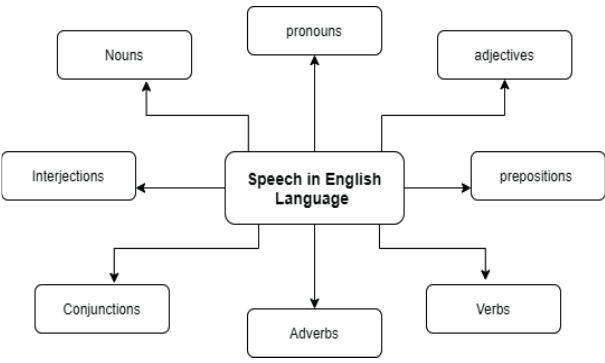
Fig. 1. Sections of speech in the English